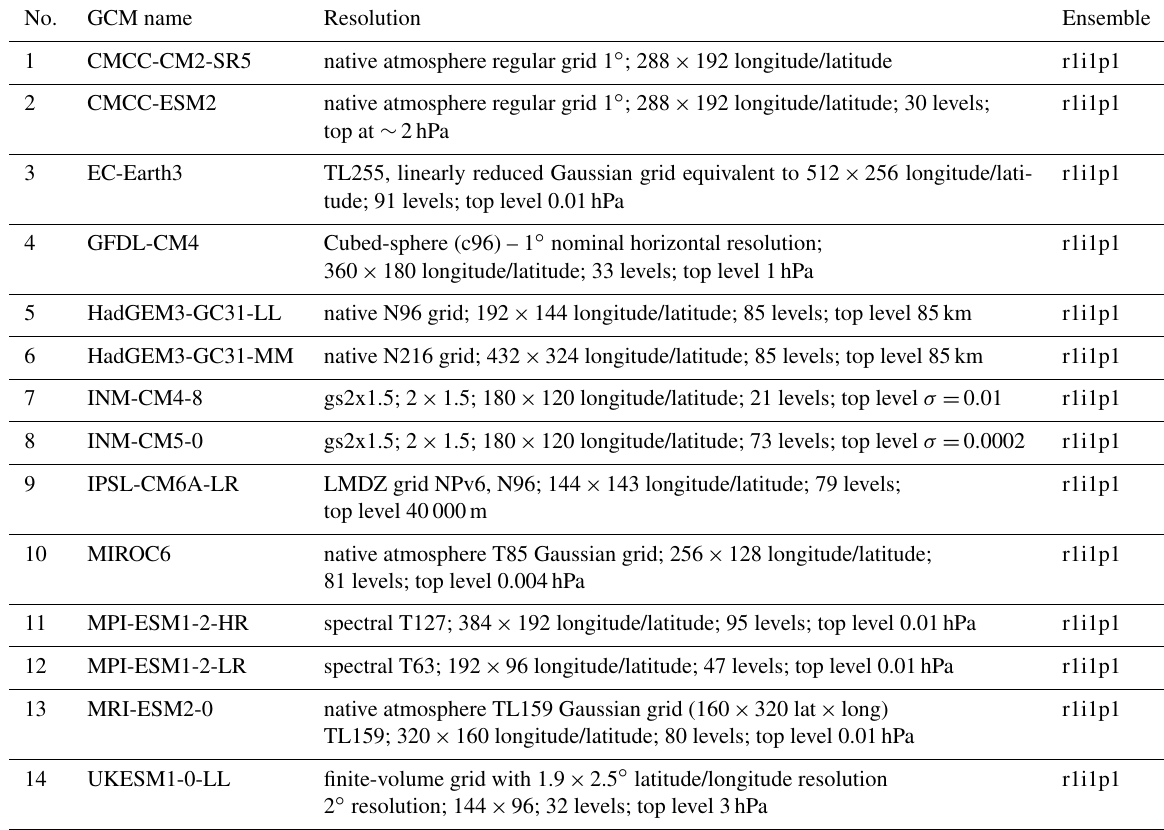
Table A1. The list of CMIP6